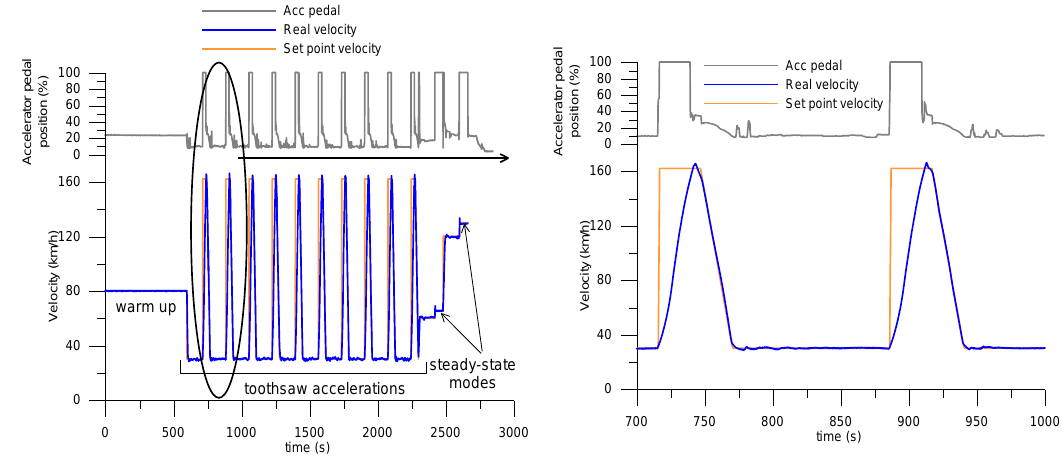
Figure 2. Driving cycle ( left ) and detail of the first accelerations ( right ).